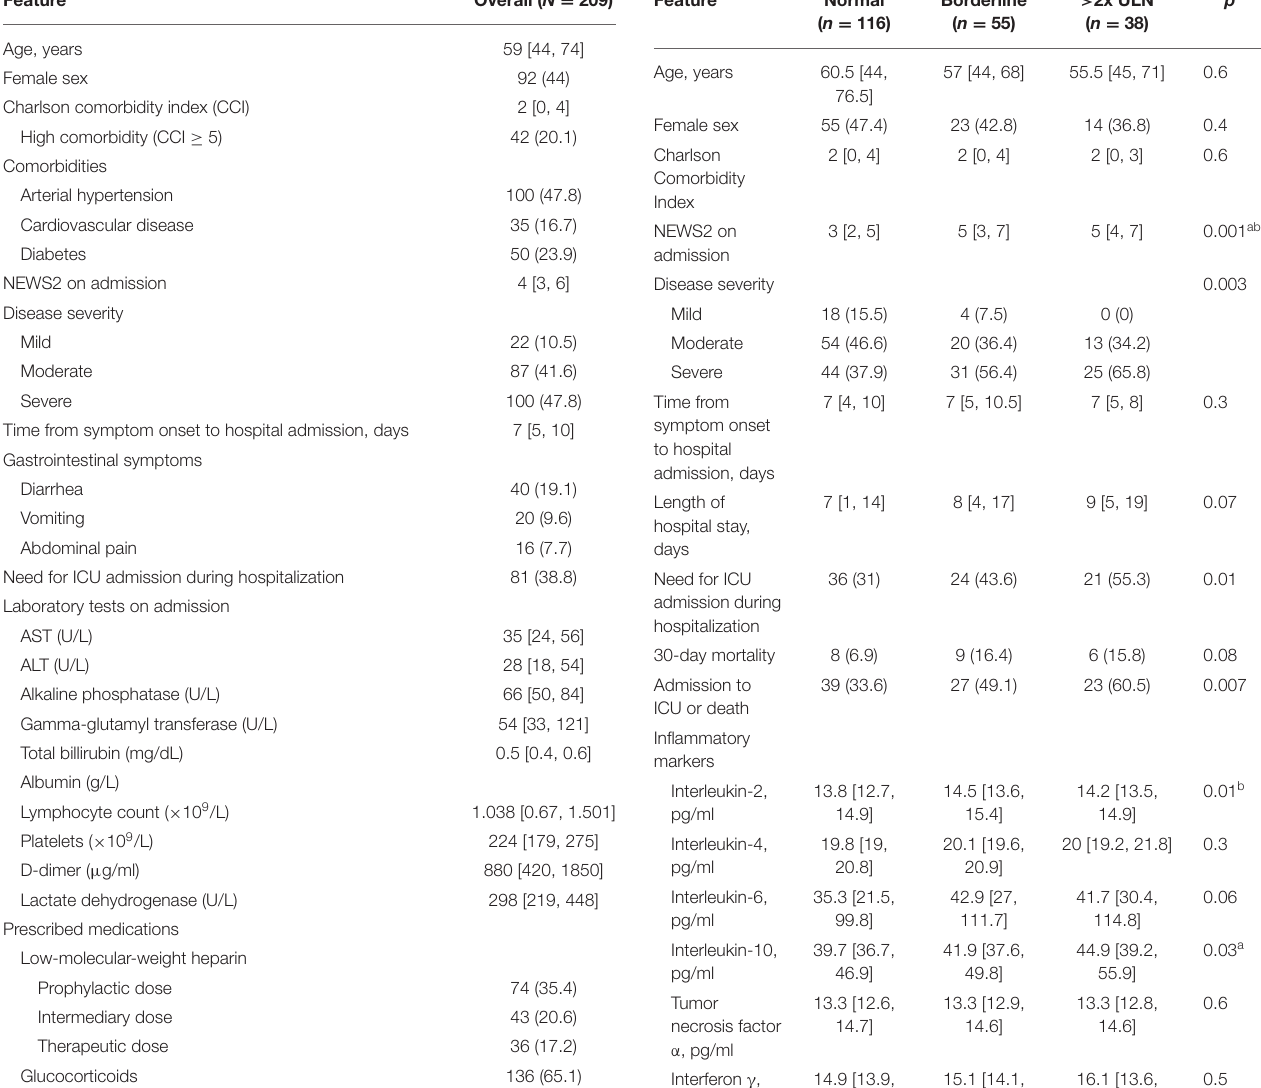
TABLE 1 | Baseline characteristics of the cohort. TABLE 2 | Characteristics of liver transaminase tests elevations.